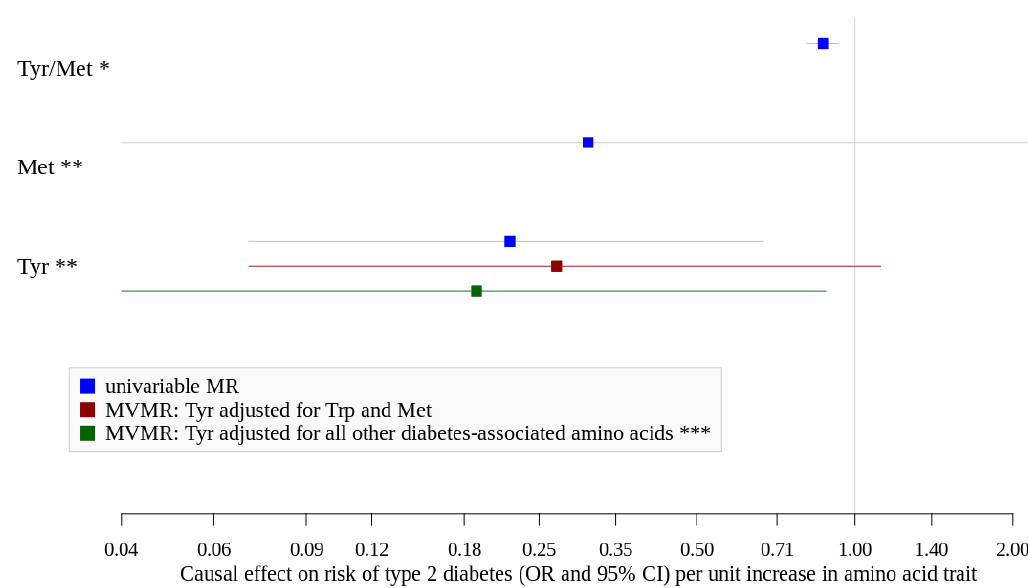
Figure 3. Causal e ff ects (OR and 95%CI) of amino acid traits and type 2 diabetes. Met, methionine; Figure 3. Causal effects (OR and 95%CI) of amino acid traits and type 2 diabetes. Met, methionine; Tyr, tyrosine. * assessed using EPIC-Potsdam GWAS data and Mahajan et al. [14], tyrosine / methionine Tyr, tyrosine. * assessed using EPIC-Potsdam GWAS data and Mahajan et al. [14] , ratio is ln-transformed and standardized. ** assessed using public GWAS data by Shin et al. [11] and tyrosine/methionine ratio is ln-transformed and standardized . ** assessed using public GWAS data Mahajan et al. [14], Met and Tyr are log 10 -transformed. *** adjusted for Tryptophan, Leucine, Isoleucine, by Shin et al. [11] and Mahajan et al. [14] , Met and Tyr are log 10 -transformed . *** adjusted for Valine, Glycine, Tryptophan, Leucine, Isoleucine, Valine, Glycine, Phenylalanine. Tyrosine showed no significant associations with BMI, waist circumference and fasting insulin, but results tended towards an inverse association with fasting blood glucose adjusted for BMI ( p = 0.008) and blood glucose ( p = 0.004). (Table S10).